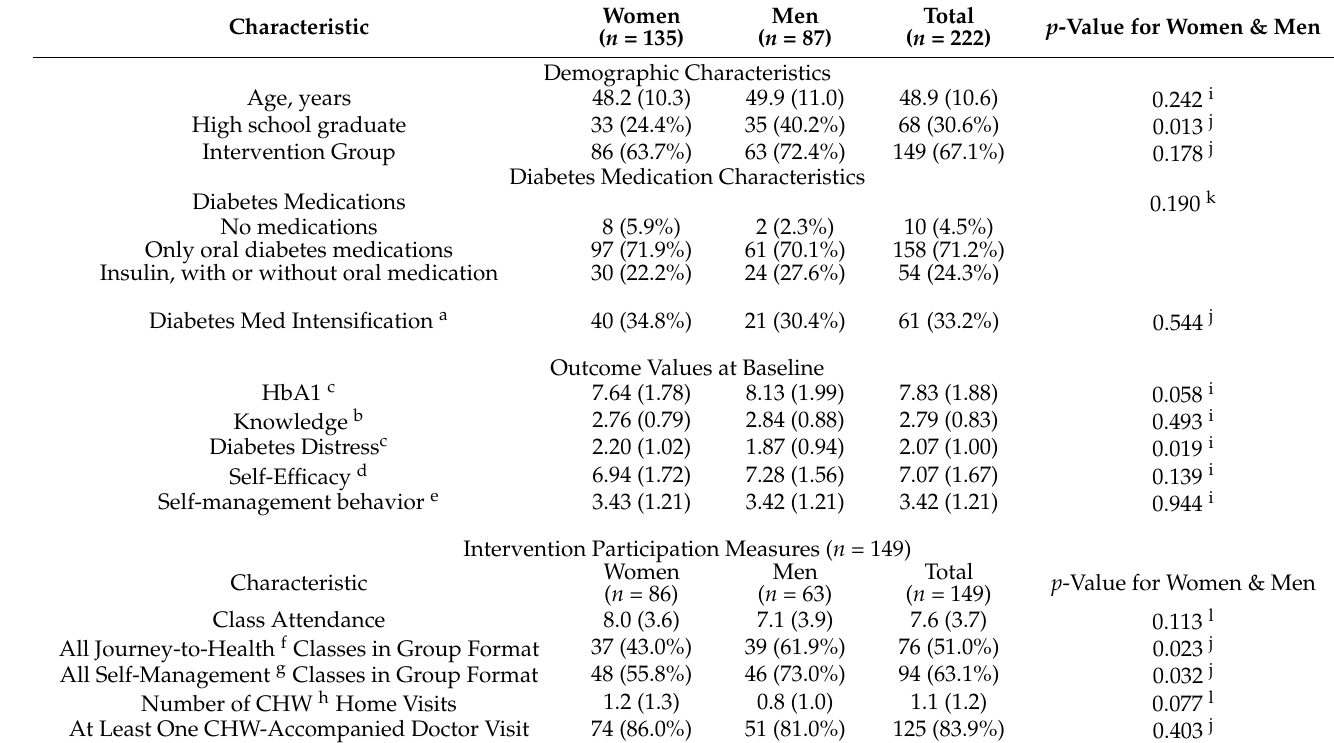
Table 1. Baseline Values, Demographics, and Participation by Gender, Mean (sd) or n